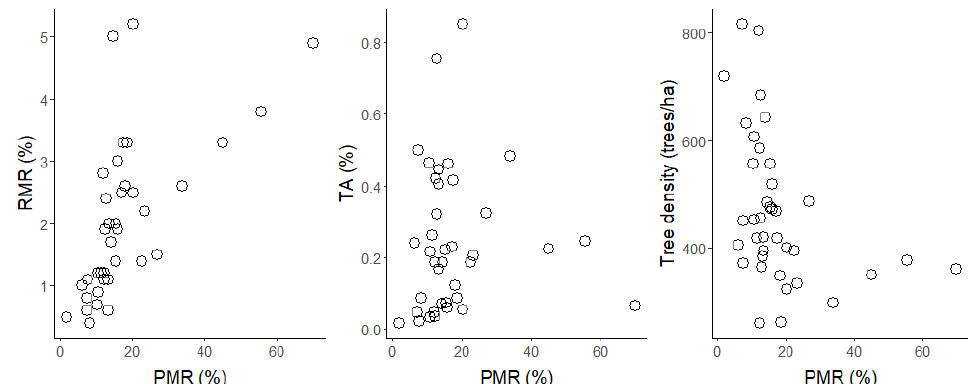
Figure 5. Stand-level relationships between the predicted mortality rate (PMR) and the reference mortality rate (RMR), percentage of trembling aspen (TA), and tree density. Please be aware of differentiating axes’ scales.